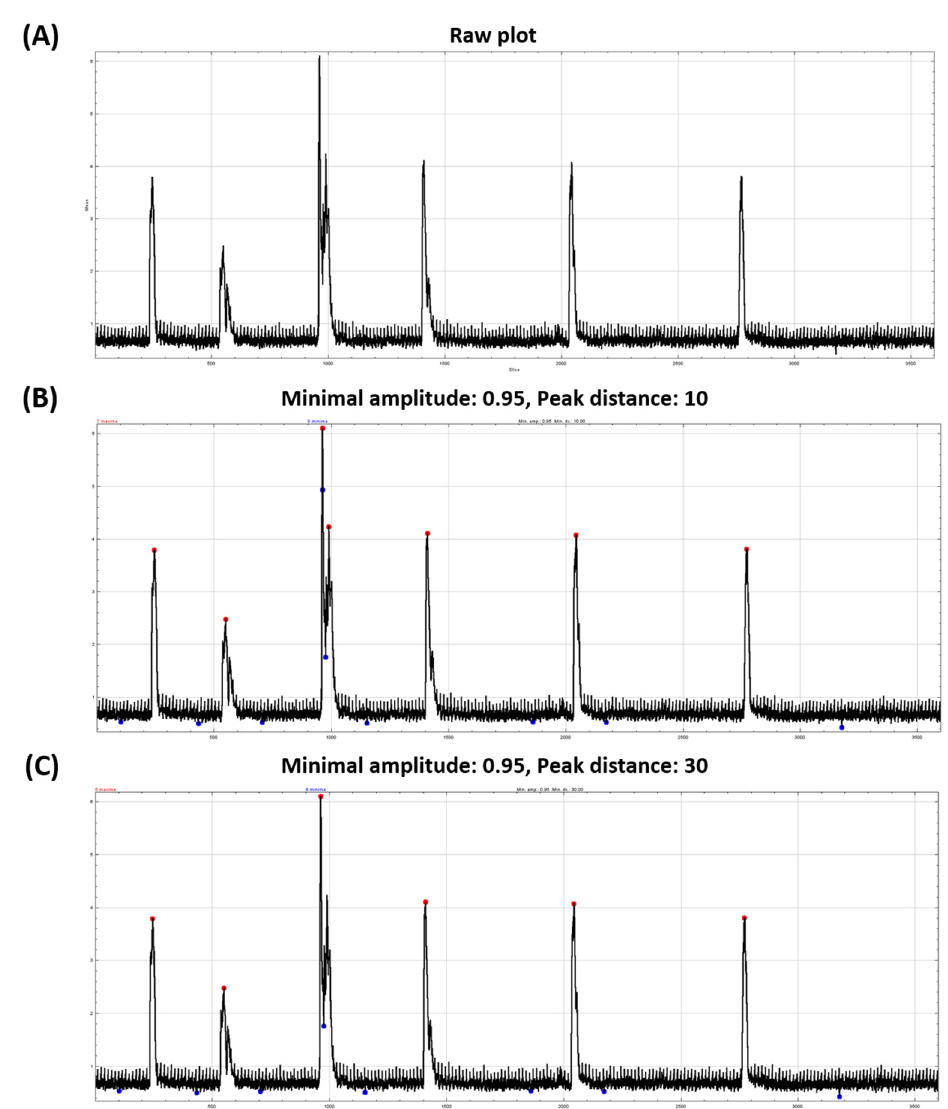
Figure 4. Tail coiling activity plot over time for zebrafish embryo tail coiling activity measurement. The x -axis represents time (frame), while the y -axis represents signal intensity. Raw tail coiling activity plot obtained from Plot Z -axis Profile tool ( A ) and peaks extracted at 0.95 minimal amplitude and different peak distance of 10 ( B ) and 30 ( C ), x -axis = video frames, y -axis = intensity. Afterward, BAR Plugin was used to collect the peaks, which represent TC